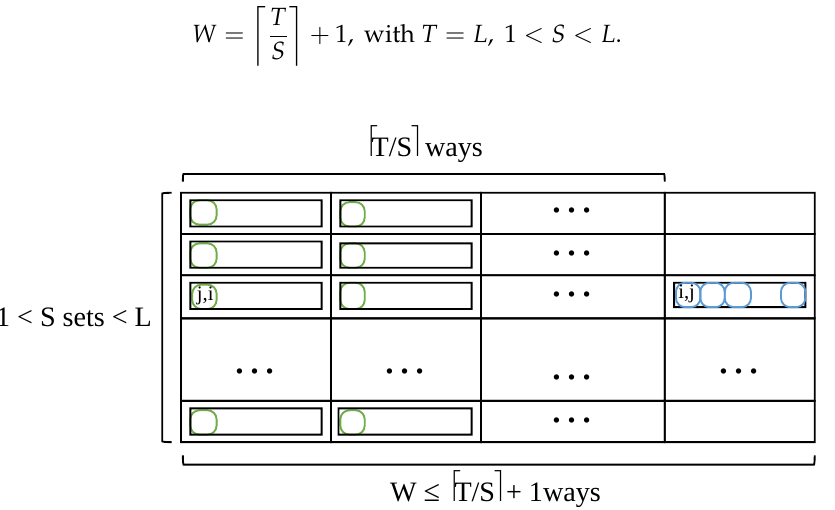
Figure 5. Set-associative cache holding a whole tile ( T = L ), with 1 < S < L